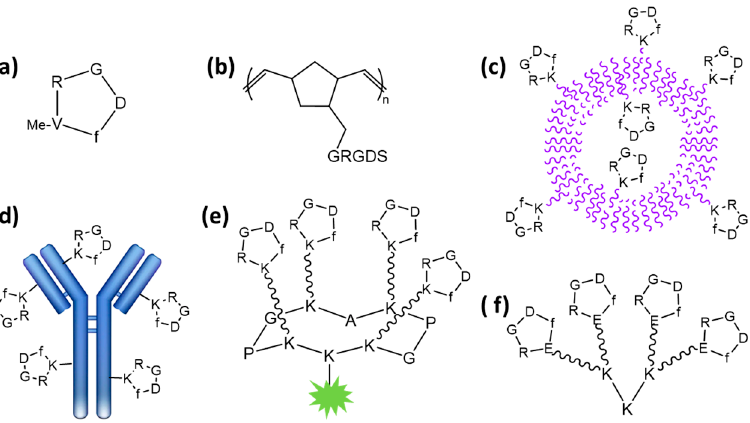
Figure 1. Structures of RGD compounds: ( a ) cilengitide [11]; ( b ) RGD-containing polynorbornene polymer [16]; ( c ) RGD-functionalized vesicle [17]; ( d ) RGD-displaying antibody [19]; ( e ) tetrameric RGD-containing cyclodecapeptide [21]; ( f ) tetrameric RGD-containing polylysine [20].